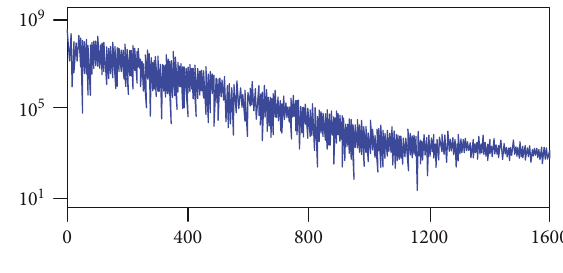
Figure 4: Power spectrum of Lorenz.